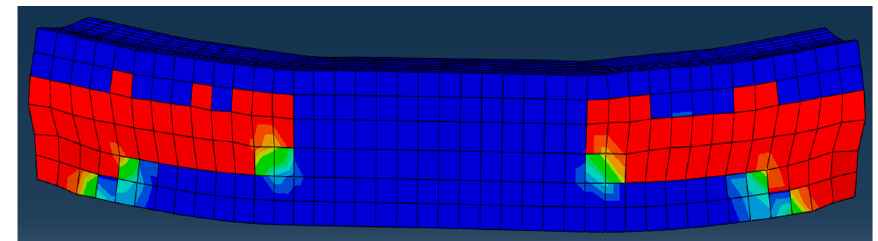
Figure 17. Damage diagram of prestressed hollow slab concrete.